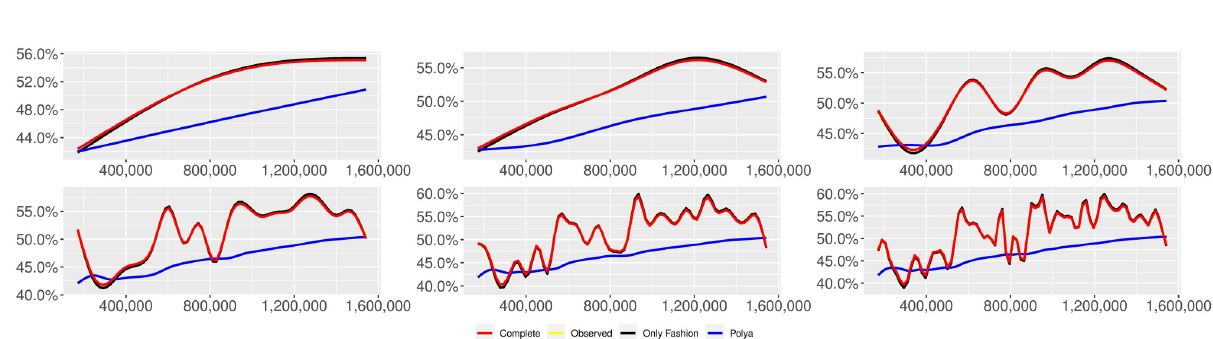
Fig 20. “10 days of traffic” ( T = 0.5, entire, D = 30 00 y, slots = days): Sentiment curves. In each panel, the yellow line is the cubic spline smoothing of the time series of the observed tweets ξ n +1 , together with the default confidence interval (gray), the red line represents the cubic spline smoothing of the time series of the estimated predictive means ^ c (defined in Subsec. 3.2), obtained with the complete RP model, the black and the blue lines provide n similar approximations obtained with the other models: black = Only fashion RP model and blue = Standard Po´lya model. In each panel, the smoothing is obtained with a given number of nodes: k = 3 (top left panel), 5 (top middle panel), 10 (top right panel), 20 (bottom left panel), 30 (bottom middle panel), 50 (bottom right panel).